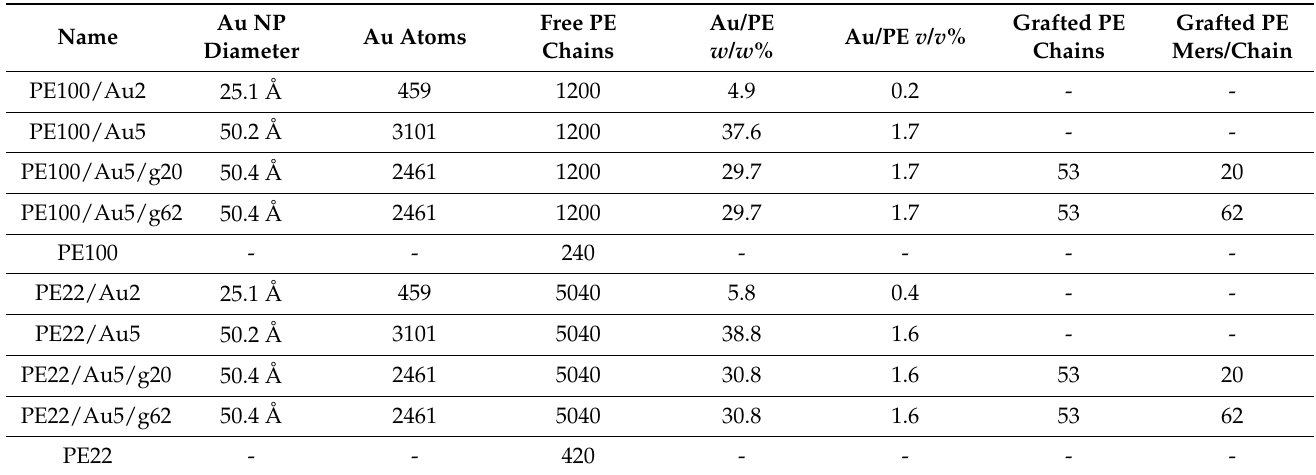
Table 1. Details of the simulated model systems.